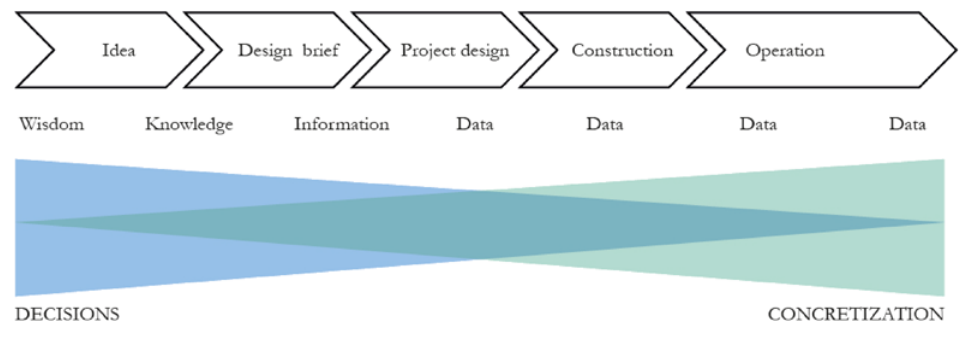
The relation between the types of knowledge that are applied and embedded in the design